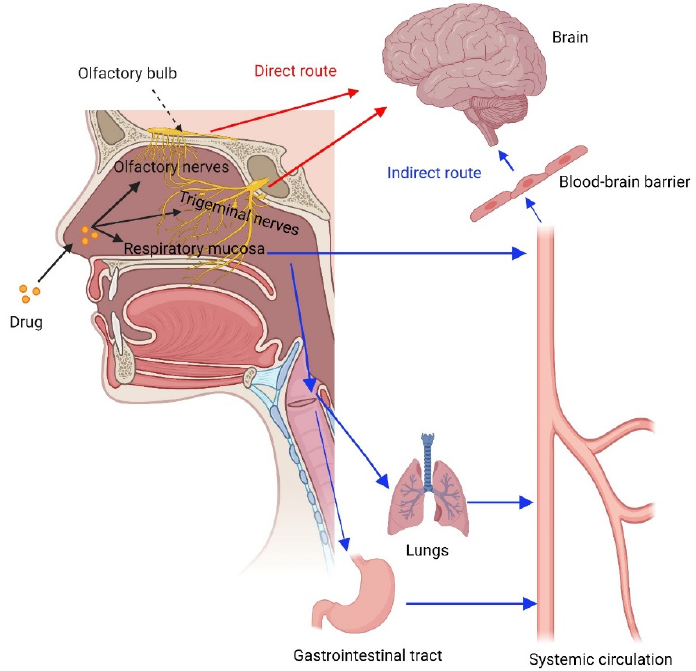
Figure 2. Transport routes of drugs from the nose to the systemic circulation and the brain.